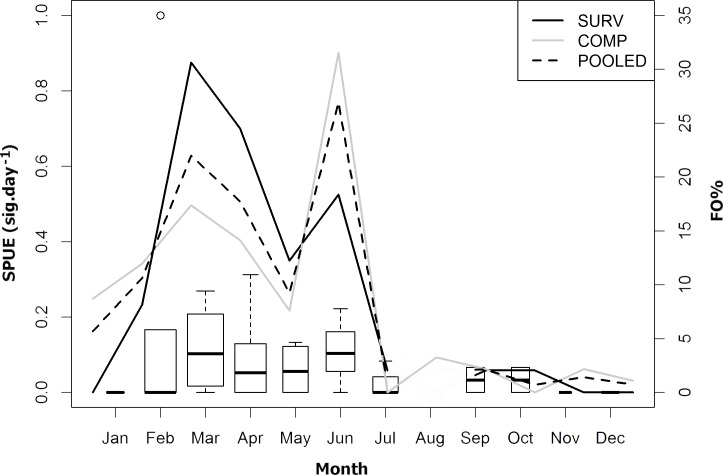
Distribution of whale shark sightings per month.Relative frequency of occurrence (FO%) per month of the SURV (n = 49; solid black), COMP (n = 92; solid grey) and POOLED (n = 141; dashed black) datasets; and SURV Sightings per Unit of Effort (SPUE; sig.day-1) per month of R. typus in the ASPSP. The width of the boxes is proportional to the square-roots of the number of observations in the groups, the horizontal bar is the median and the open circle indicates a single outlier.